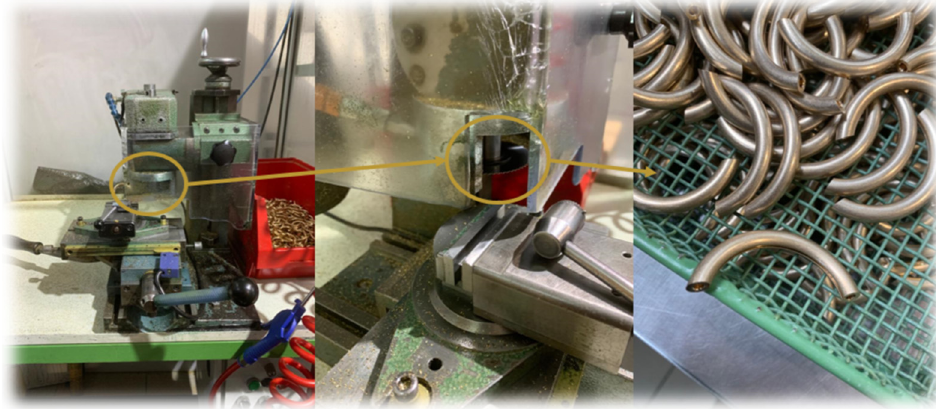
Figure 4. Conventional milling